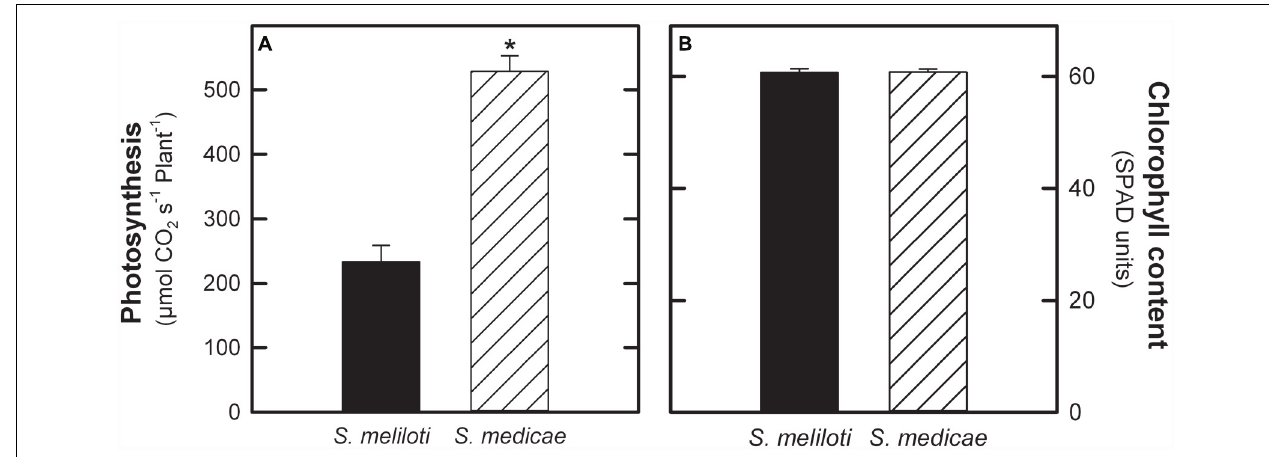
FIGURE 2 | Photosynthesis rates (A) and chlorophyll content (B) in M. truncatula inoculated with either S. meliloti 2011 or S. medicae WSM419. Values represent mean ± standard deviation ( n = 5). An asterisk (*) denotes significant differences (Student’s t -test at p ≤ 0.05).